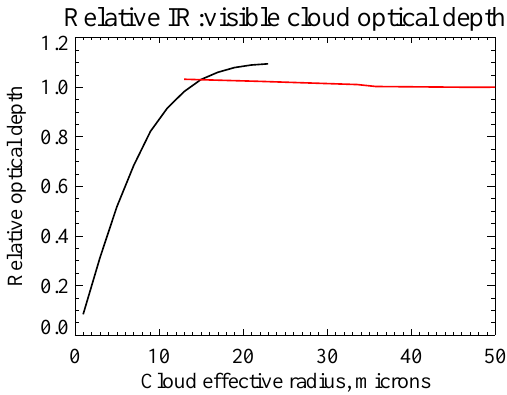
Fig. 8. Ratio of cloud IR optical depth to visible optical depth, τ c , IR : τ c , as a function of cloud effective radius. The black line indicates water clouds, and the red line ice clouds.